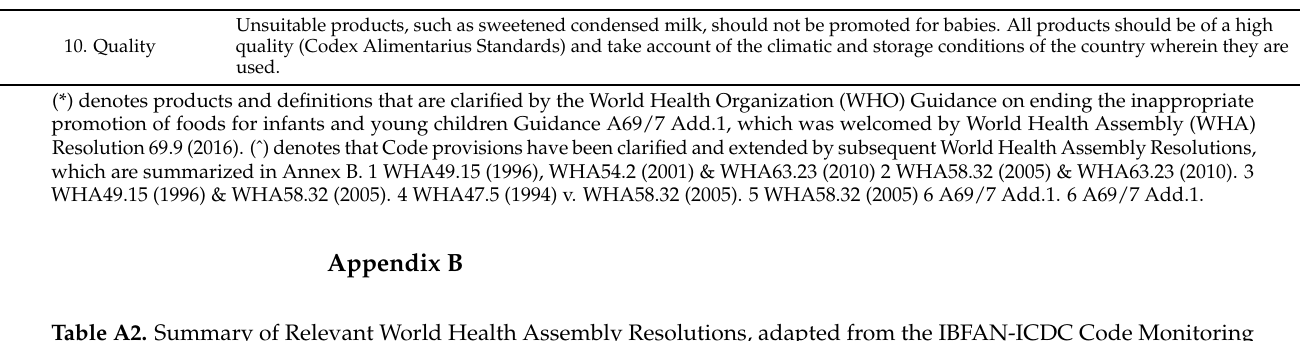
Table A2. Summary of Relevant World Health Assembly Resolutions, adapted from the IBFAN-ICDC Code Monitoring Kit